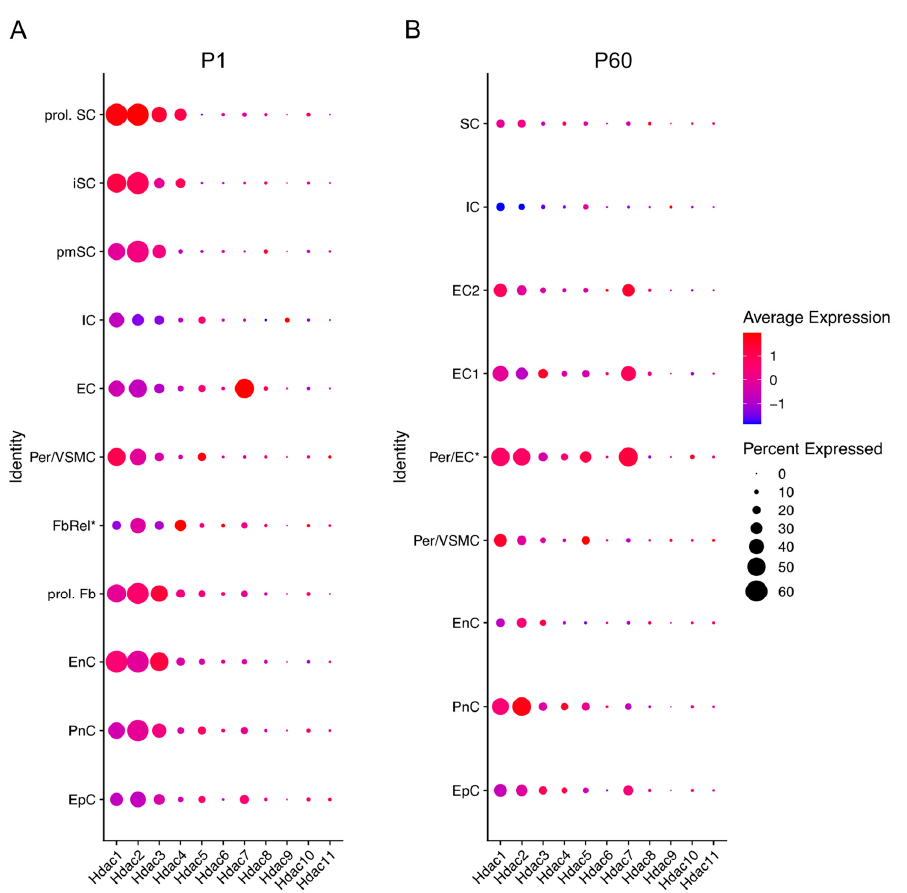
Figure 3. Hdac expression across different cells in the sciatic nerve at ( A ) P1 (early developmental stage) and ( B ) P60 (mouse adulthood). Data based on 10 × genomics single cell RNA sequencing data from Gerber et al. (2021). Graphs generated based on RNA-seq data from Gerber et al., 2021 (GEO data- base accession number GSE137870). [56]. Three independent samples were included for each time point, processed as three independent 10× Genomics runs. Expression is detailed in proliferating (prol. SC), immature (iSC), and pro-myelinating (pmSC) Schwann cells; immune cells (IC), endothe- lial cells (EC), pericytes, and vascular smooth muscle cells (per/VMSC), pericytes/endothelial cells (Per/EC*), endothelial cells 1 and 2 (EC1&2), proliferating fibroblast-like cells (prol. Fb), fibroblast- related cells (FbRel*), endoneurial cells (EnC, also known as endoneurial fibroblasts or fibroblast- like cells), perineurial cells (PnC), and epineurial cells (EpC). Dot colour represents average expres- sion level in cells expressing the Hdac of interest. Dot size represents percentage of cells expressing the Hdac of interest. (* indicates tentative label suggested by Gerber et al., 2021). Futher single cell RNA-seq gene expression can be checked in the Sciatic Nerves Atlas: https://snat.ethz.ch/index.html (Accessed on 26 February 2022). Hdac8 and Hdac10 show low expression levels overall, while Hdac9 is undetectable in nerves after birth. These Hdac subtypes are mainly expressed in epineurial, perineurial, and endoneurial cells (Figure 3) [56]. 3.4. The Role of HDACs in Repair Schwann Cells and Remyelination To understand the role of HDACs in nerve regeneration and repair SC reprograming, the use of HDAC inhibitors and genetically modified organisms, predominantly mutant mice, is essential. Kim et al., (2019) used a reversible HDAC class I and II inhibitor, Tri- chostatin A (TSA), to study the role of HDACs in nerve regeneration. TSA is an